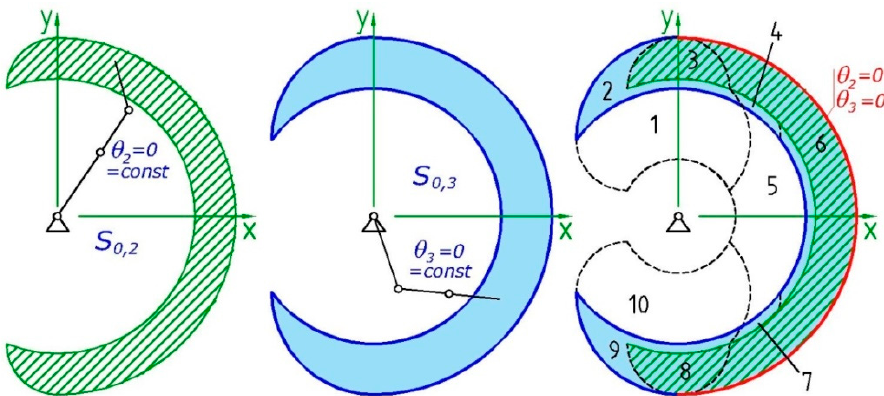
Figure 19. Areas reachable with relative singularity configurations of type S 0,2 , S 0,3 ( left and center ) and their location relative to the other areas ( right ).